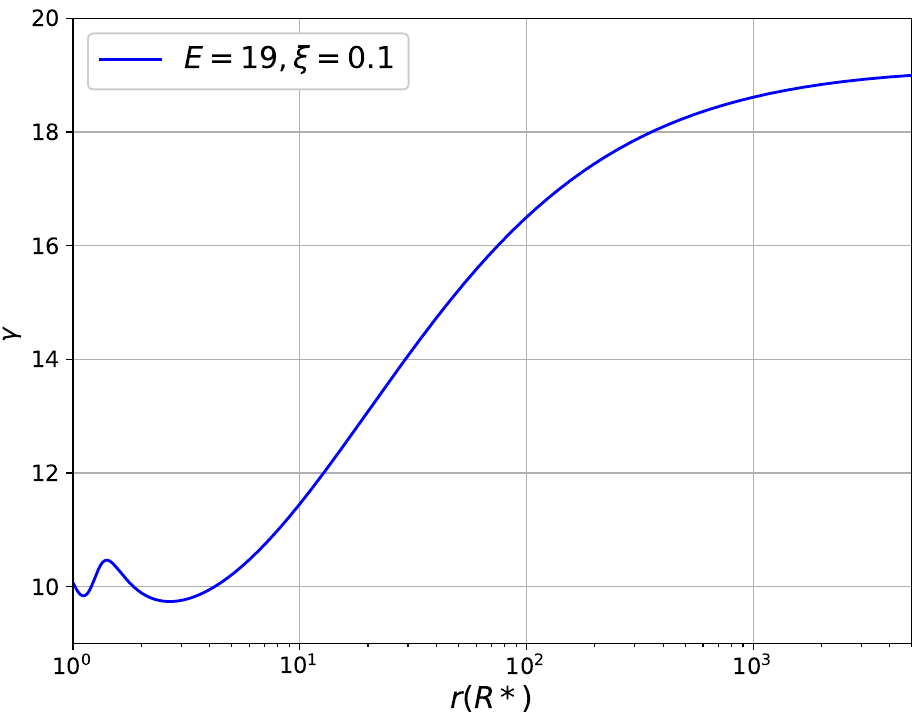
Figure 11. Jet Lorentz factor profile γ for jets with supersonic injection with γ = 10 at R = R ∗ . Here m = 0.8, ξ = 0.1 and E =